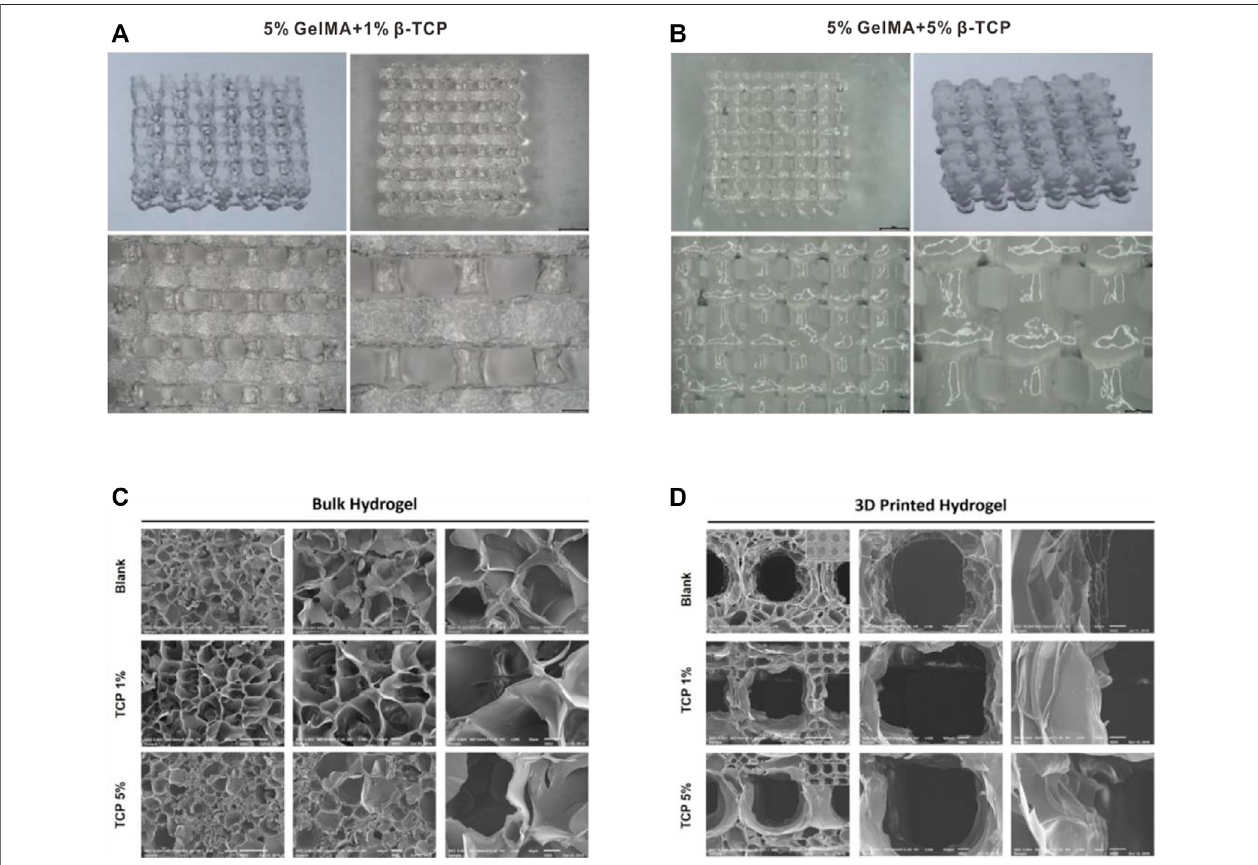
FIGURE 1 | Morphological characteristics of gel scaffolds. Morphology of hydrogels composed of 5% GelMA (w/v) with 1% β -TCP (w/v) (A) and 5% GelMA (w/v) with 5% β -TCP (w/v) (B) . Lyophilized hydrogels observed by scanning electron microscopy (C) . 3D printed hydrogel scaffolds observed by scanning electron microscopy (D)